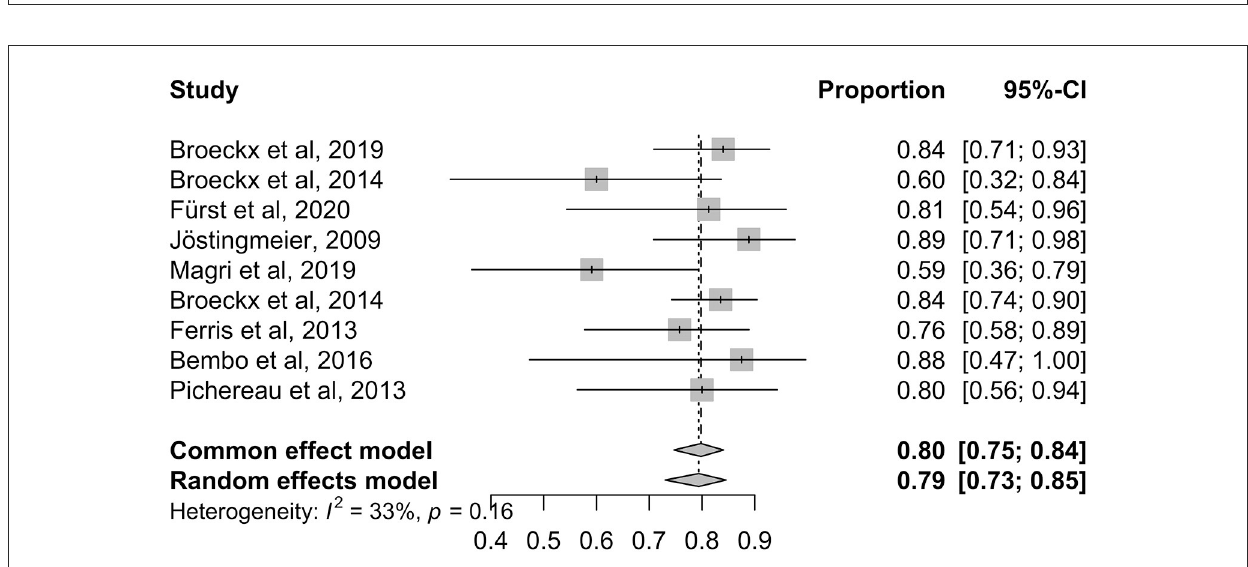
FIGURE5 Shows the ratios of the individual studies in the systematic analysis graphically without outliers.